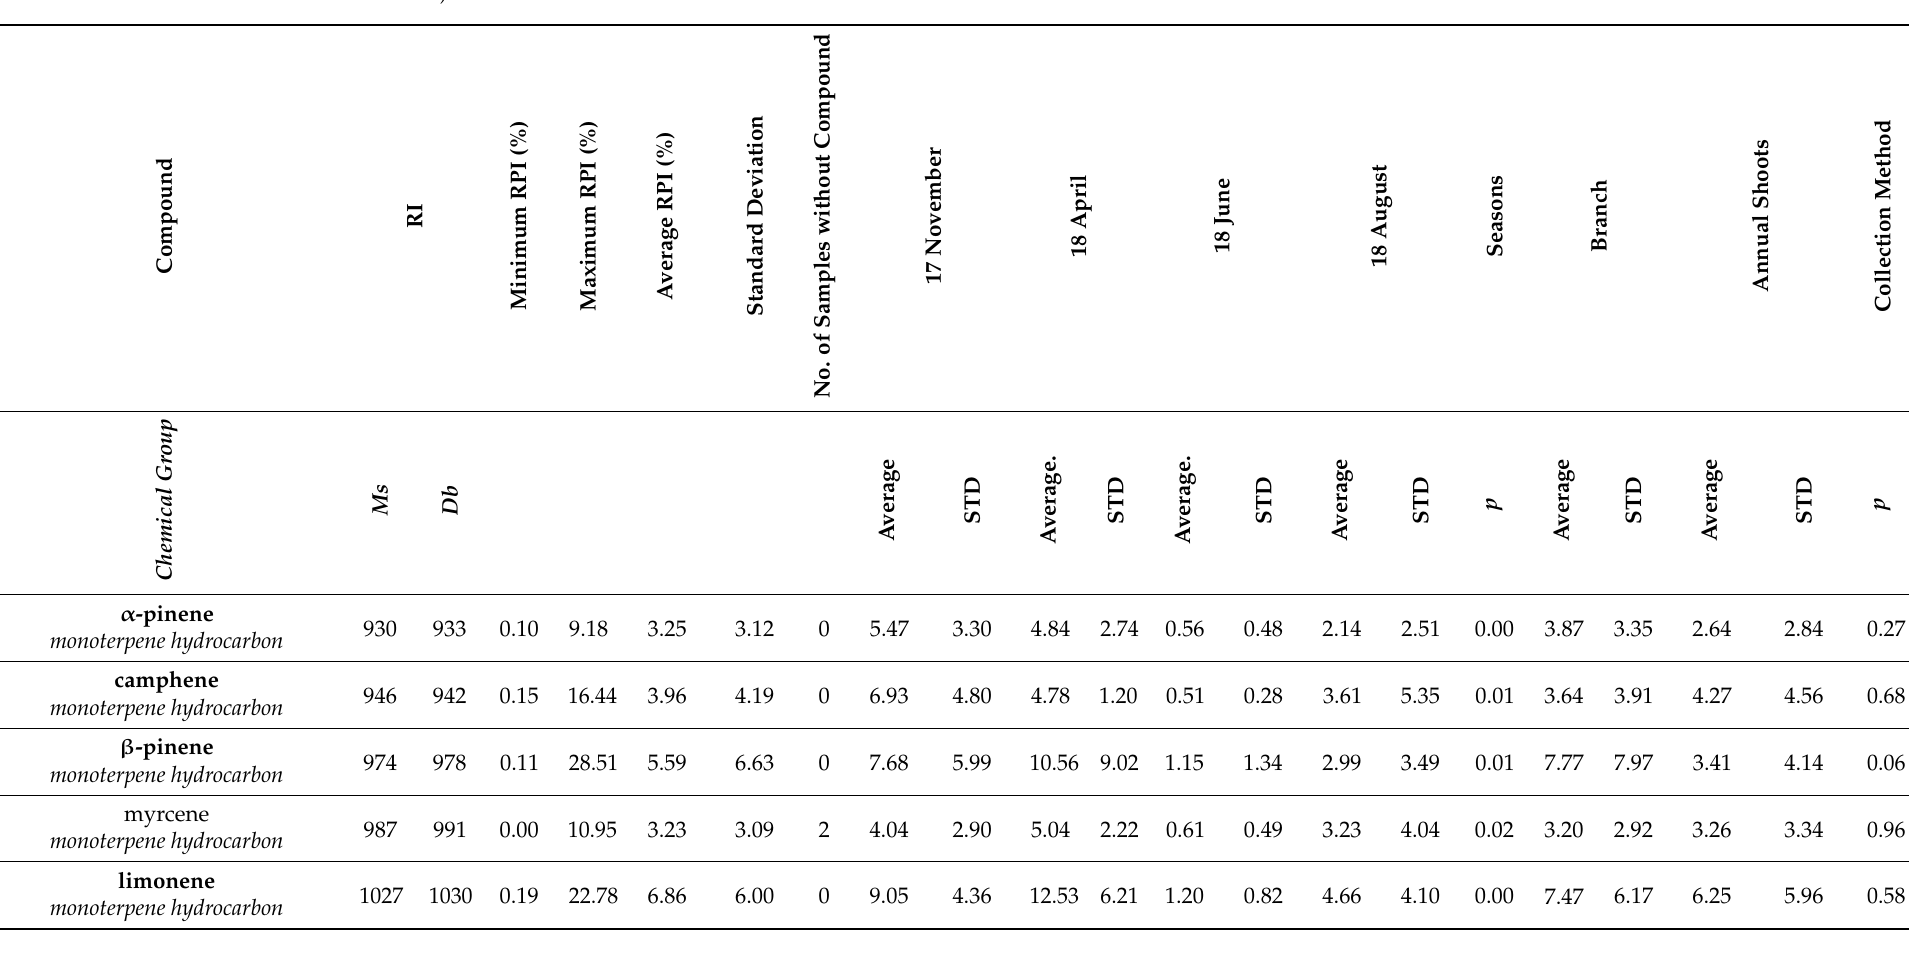
Table 2. List of volatile compounds whose average abundance, according to their relative peak intensity (RPI) (Area %), was greater than 1.5% in 32 essential oil samples, with their minimum, maximum, and average abundance obtained at different season times and with different plant parts with included p -value as detected by gas chromatography-mass spectrometry. The compounds were identified based on their mass spectra and retention indices (RI; Db, database RI; Ms, measured